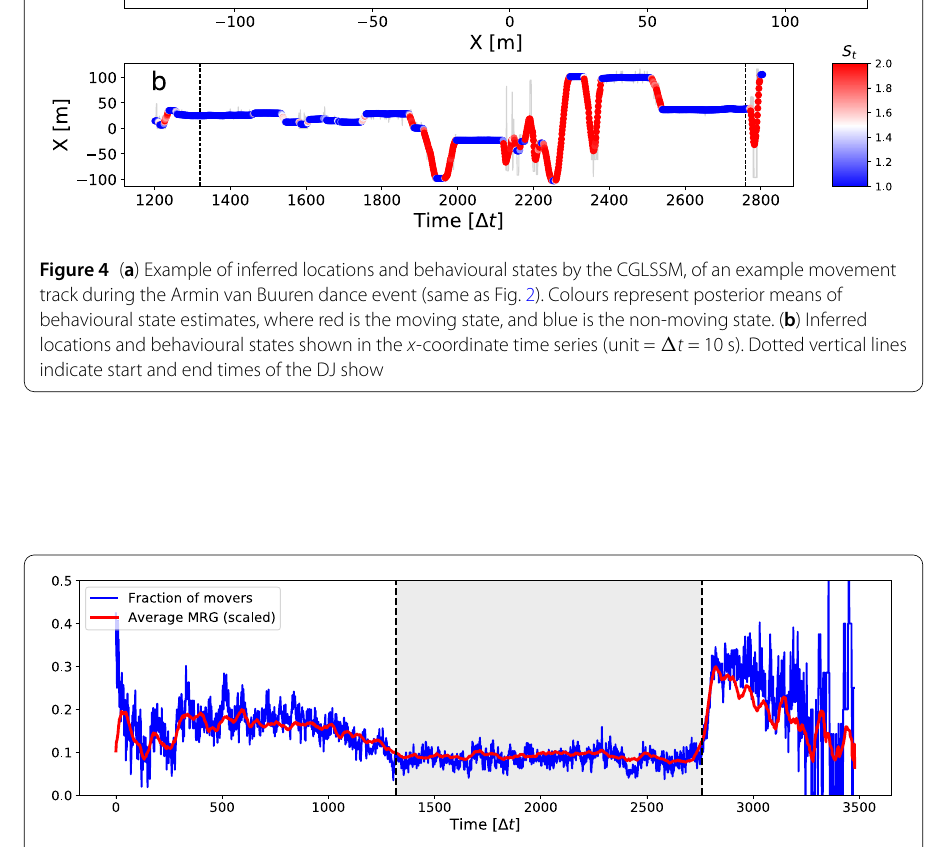
Figure 5 Time evolution of the fraction of individuals inferred as moving (blue), together with the average MRGs (red) (unit = (cid:2) t = 10 s). As a visual aid, the average MRGs graph is scaled so that it overlays f i . The two graphs evolve